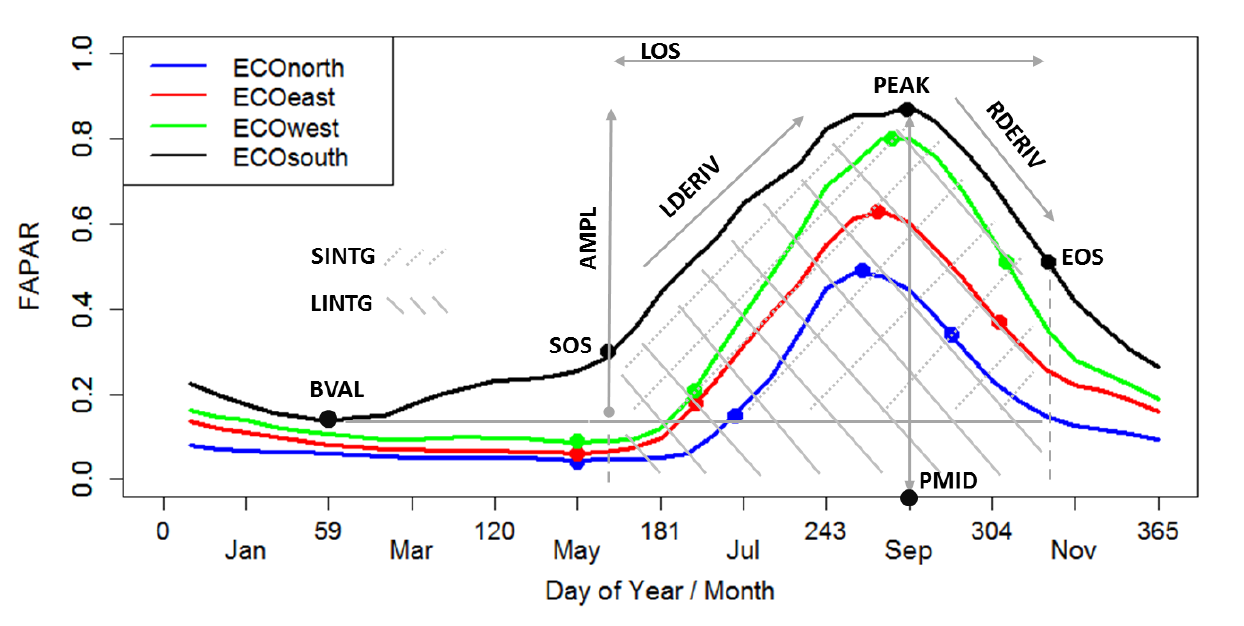
Figure 3. Mean annual GEOV1 FAPAR time series for the four ecoregions in the study